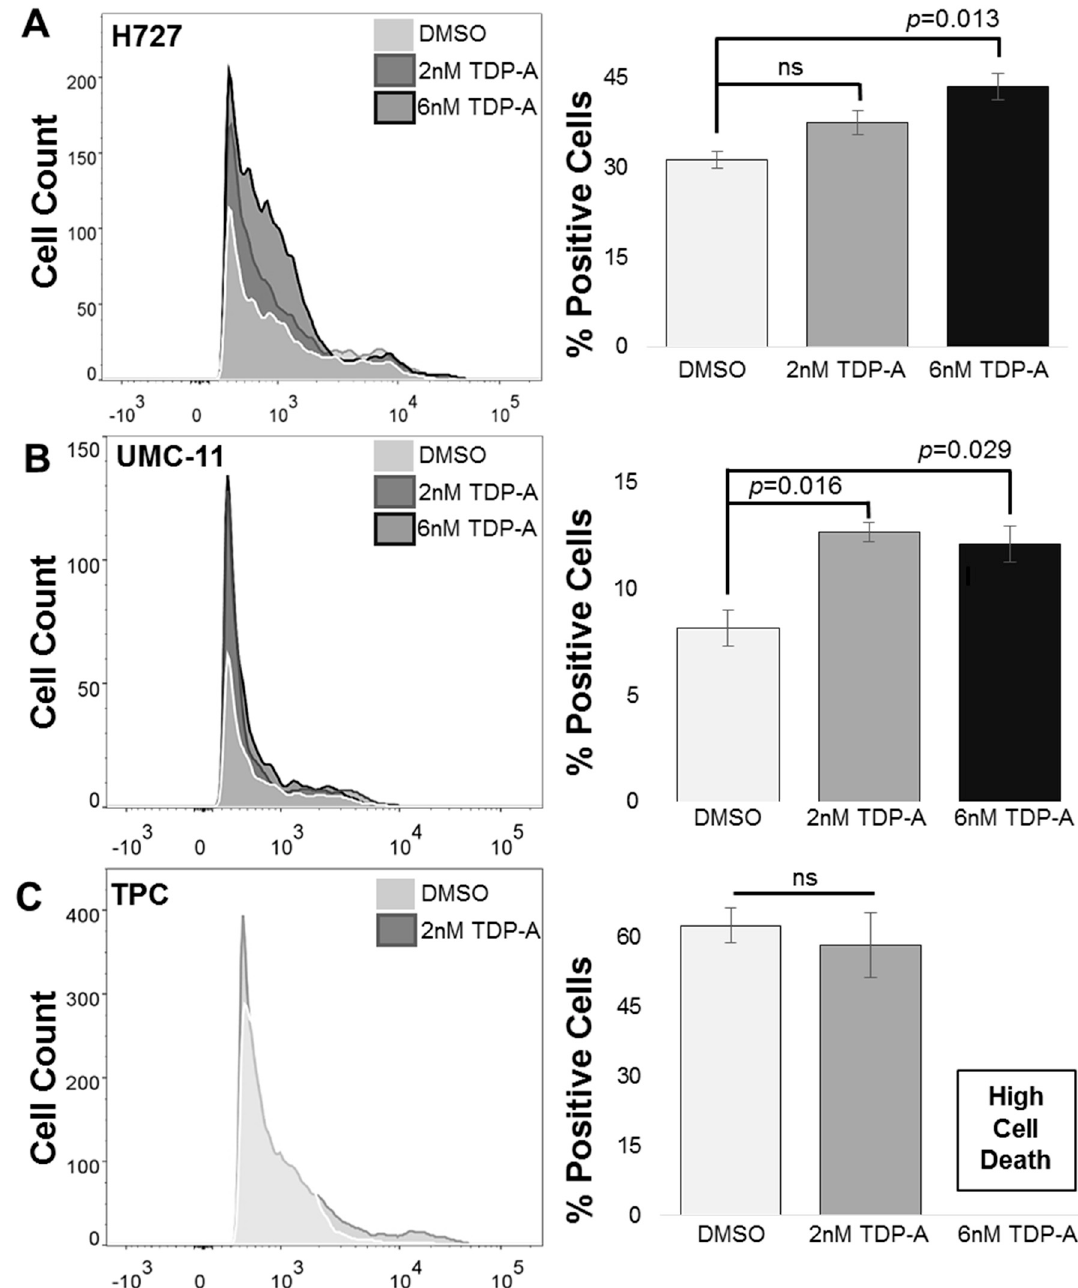
Figure 4. Increase in surface SSTR2 incidence. ( A ) The pulmonary carcinoid cell line H727 showed a significant increase in the percentage of cells expressing SSTR2 after being administered 6 nM of TDP- A ( B ) UMC-11, another pulmonary carcinoid cell line, showed significant increases in the percentage of SSTR2-positive cells after receiving either 2 nM or 6 nM of TDP-A ( C ) A papillary thyroid carcinoma cell line, TPC, did not show any change in SSTR2 expression after TDP-A administration. ns: not significant.